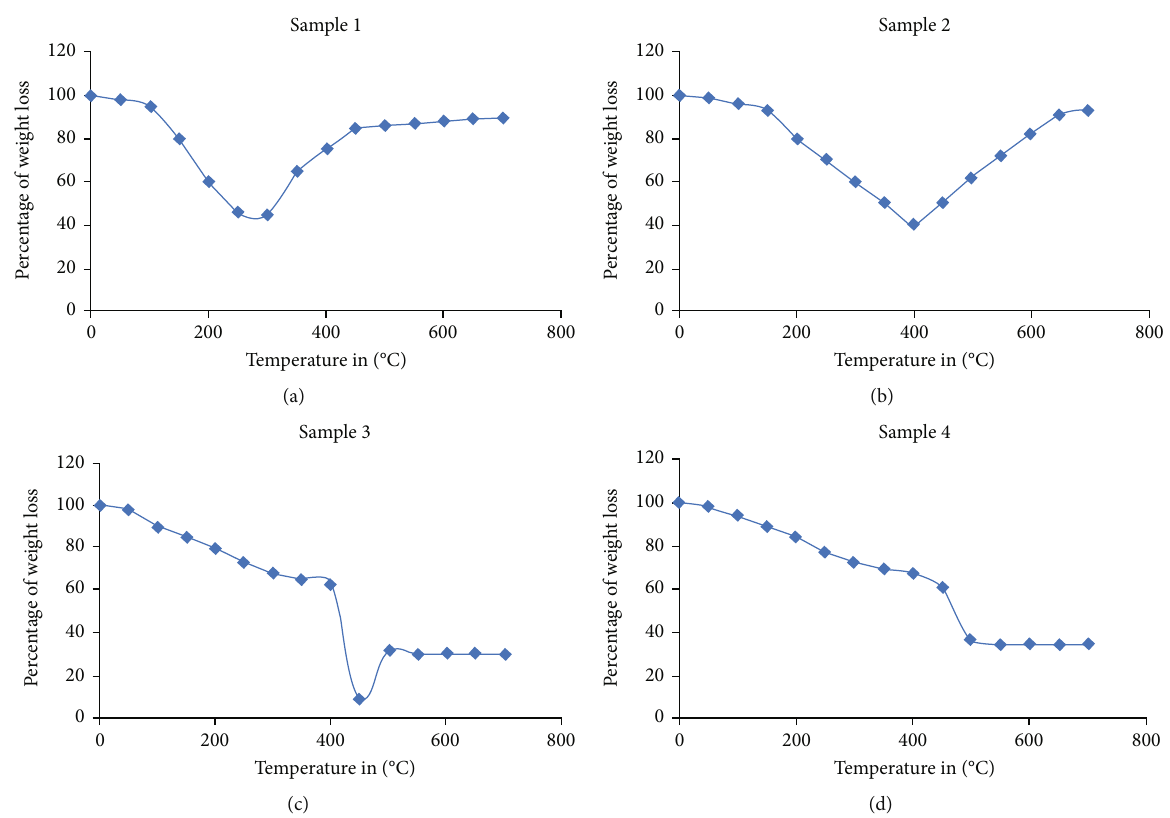
Figure 4: (a) Thermal adsorption on weight loss percentage of hybrid composite sample 1. (b) Thermal adsorption on weight loss percentage of hybrid composite sample 2. (c) Thermal adsorption on weight loss percentage of hybrid composite sample 3. (d) Thermal adsorption on weight loss percentage of hybrid composite sample 4. Table 2: Weight-loss percentage of various thermal adsorption conditions. Sample